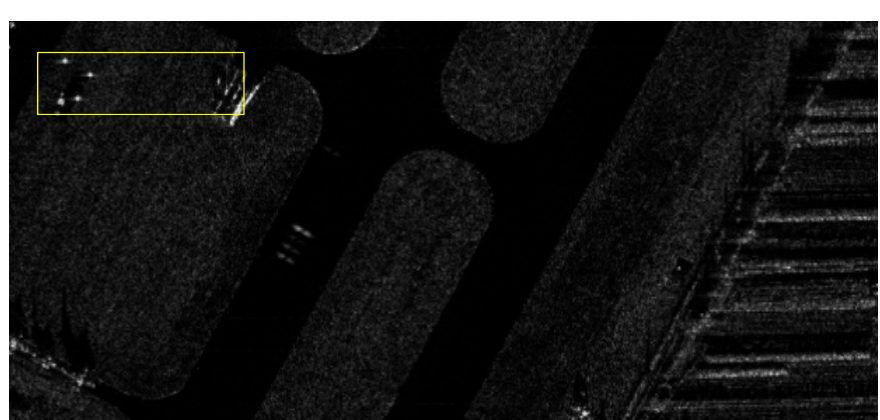
Figure 9. SAR images processed by piecewise constrained STAP.